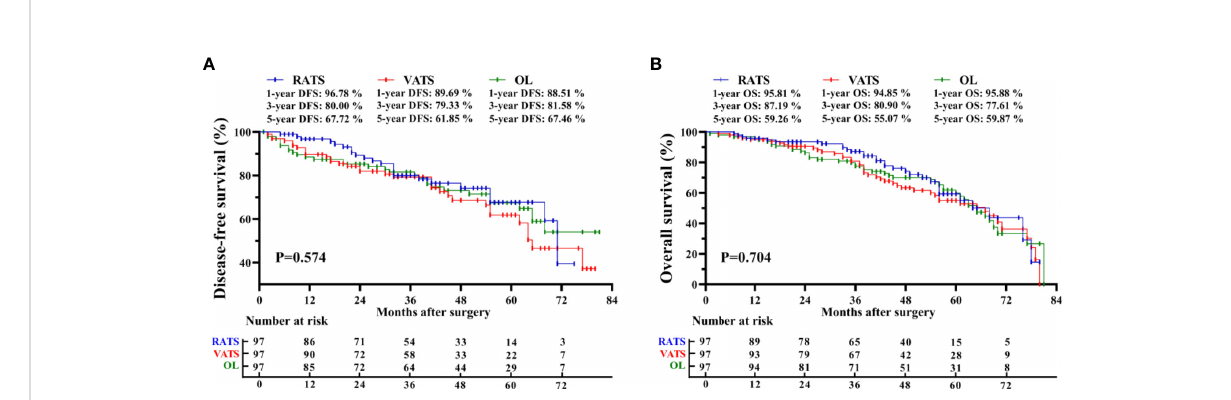
FIGURE 1 Kaplan-Meier survival curve of matched patients. Comparison of disease-free survival (A) and overall survival (B) among the RATS, VATS, and OL groups. RATS, robotic-assisted thoracoscopic surgery; VATS, video-assisted thoracoscopic surgery; OL, open